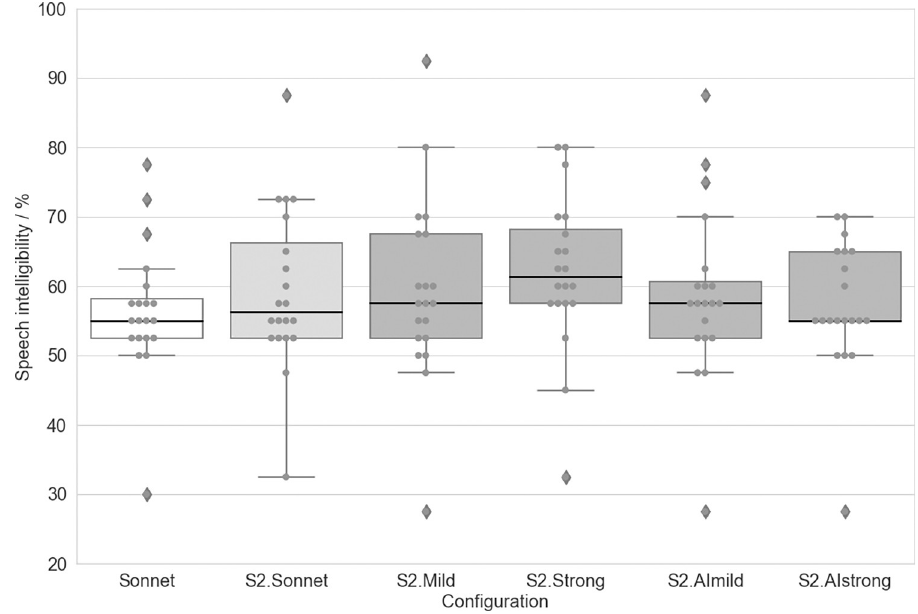
Fig 2. Speech intelligibility in quiet with each configuration. Boxplots show median values as well as first and third quartiles. Whisker bars show minimum and maximum values within 1.5 interquartile ranges below and above the first and third quartile. Diamonds show outliers.